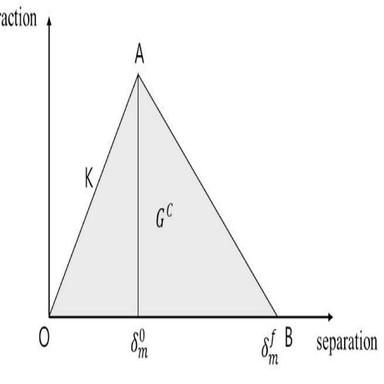
Typical traction-separation response.